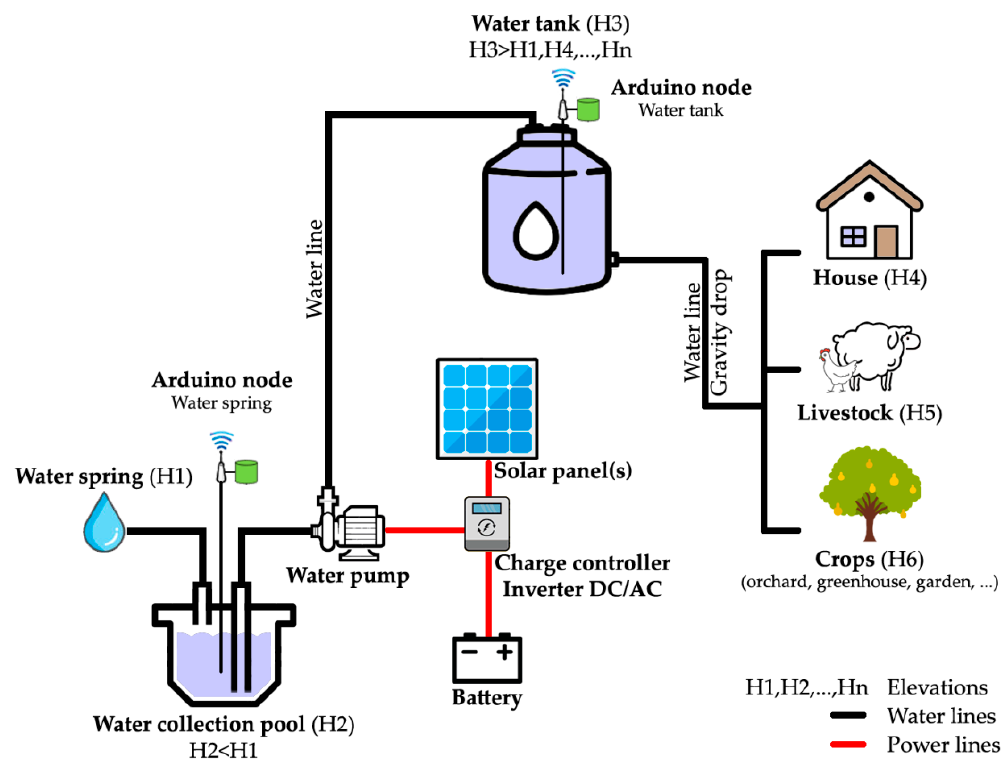
Figure 9. Autonomous wireless water management system in mountainous homestead.